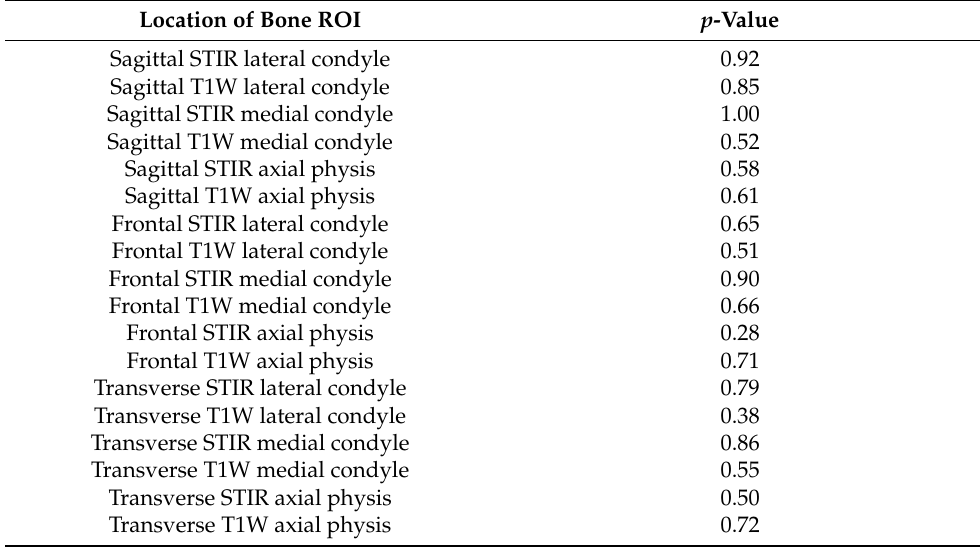
Table 1. Test of statistical difference between fresh and thawed blinded signal to noise ratio (SNR) values.